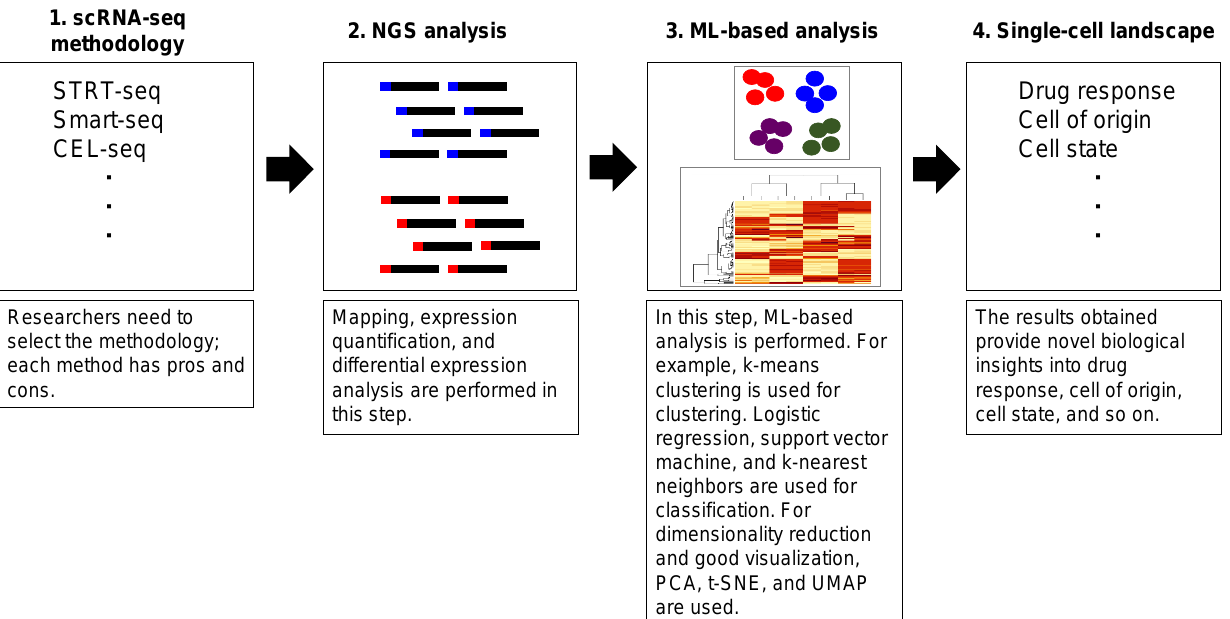
Figure 2. Schematic diagram of pipeline of scRNA-seq analysis. NGS data (input data or big data) is converted to actionable data using ML. Although each scRNA-seq technology has its own optimized protocol, in general, tissues or cells are first dissociated to disaggregated into single cells. At this point, high cell viability (>70%) and less than 30 μm of cell size in diameter are required from fresh samples to extract RNA. Then, using isolated RNA, cDNA is synthesized for NGS. NGS data (input data or big data) is converted to actionable data using ML such as cell type identification (classification) or subtypes identification (clustering). The obtained results (output) should be carefully reviewed if they support the research hypothesis. Besides, it is also possible to come up with new ideas with obtained scRNA-seq results.